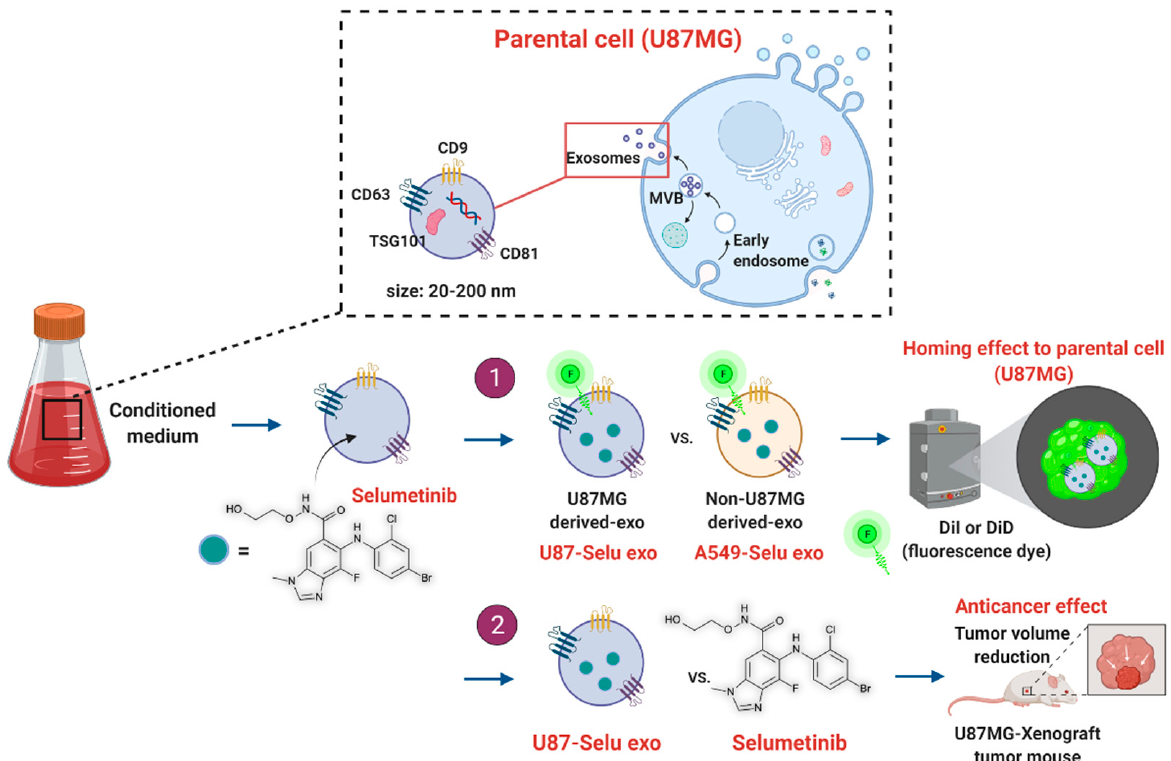
Figure 1. Experimental design of anticancer drug-loaded U87MG exosome.